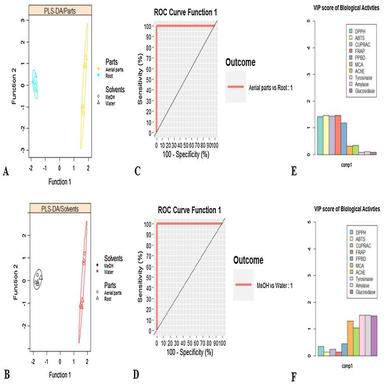
Supervised Partial Least Squares Discriminant Analysis. A&B: Score plot of samples. C&D: Area Under the Curve average and Receiver Operating Characteristic Curve using one-vs-all comparisons reflecting the goodness of the supervised model. E&F: Discriminant biological activities evaluation by VIP approach.